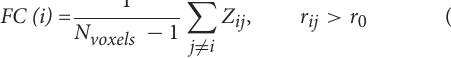
sensitivity and specificity with less inclusion of artifacts from vascular signals. For each subject, before ALFF/fALFF calculation, spatial smoothing (Gaussian kernel of full-width half maximum, FWHM = 6 mm) was performed. For